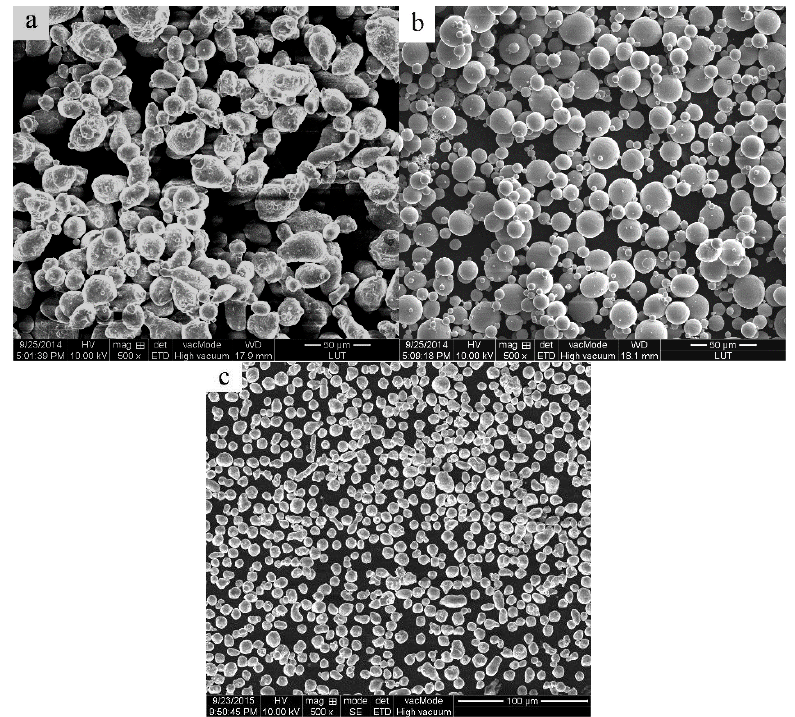
Figure 1. SEM micrographs of the as-received powders. ( a ) 2024 Al p ; ( b ) Ti p ; ( c ) Al p .